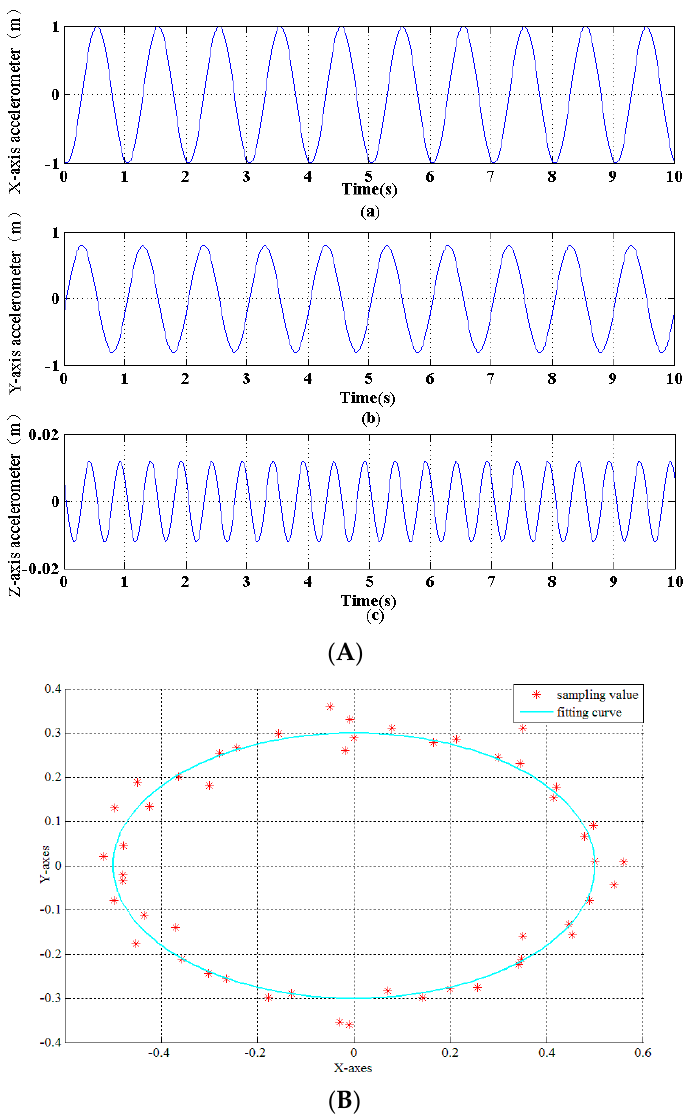
Figure 17. The displacement fitting at a single monitoring point: ( A ) Motion displacements of a single node; ( B ) Trajectory of a single point in a cycle (view from the Z-axis). Table 1. Experimental data of the elliptical motion.